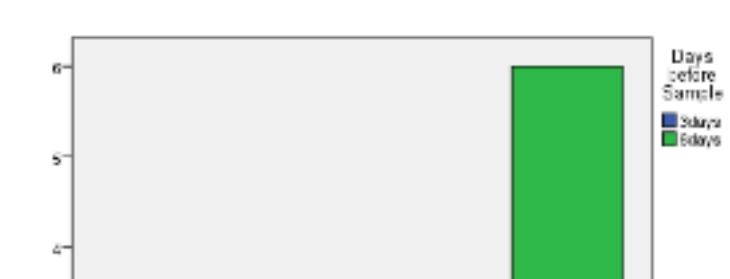
Figure 10. Parietal pleura inflammation 3 vs. 6 days of PRP. o With talc, there was a statistically significant difference in the inflammation provoked in 6 days compared to 3 days regarding parietal pleura ( p = 0.002) (Figure 11); regarding visceral pleura, this could not be measured, as inflam- mation was high in both groups (grade II–III).